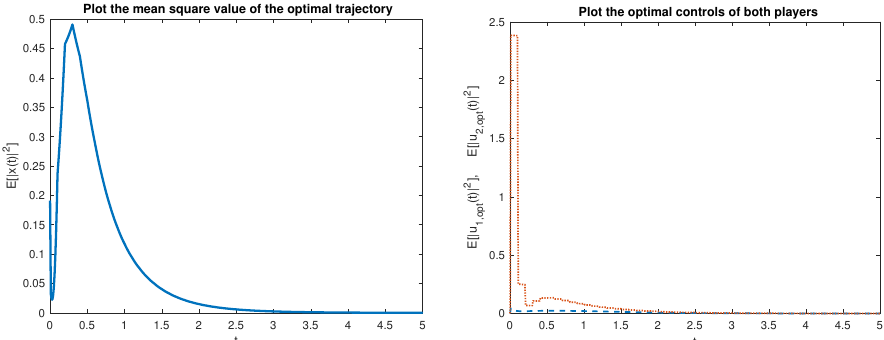
Figure 3. ( left ) E [ | ˜ x ( t ) | 2 ] ; Interval [ t 0 , τ ] = [ 0,1 ] ; ( right ) E [ | u 1, opt ( t ) | 2 ] and E [ | u 2, opt ( t ) | 2 ] ; Interval [ t ] = [ 0,1 ] . 0 , τ